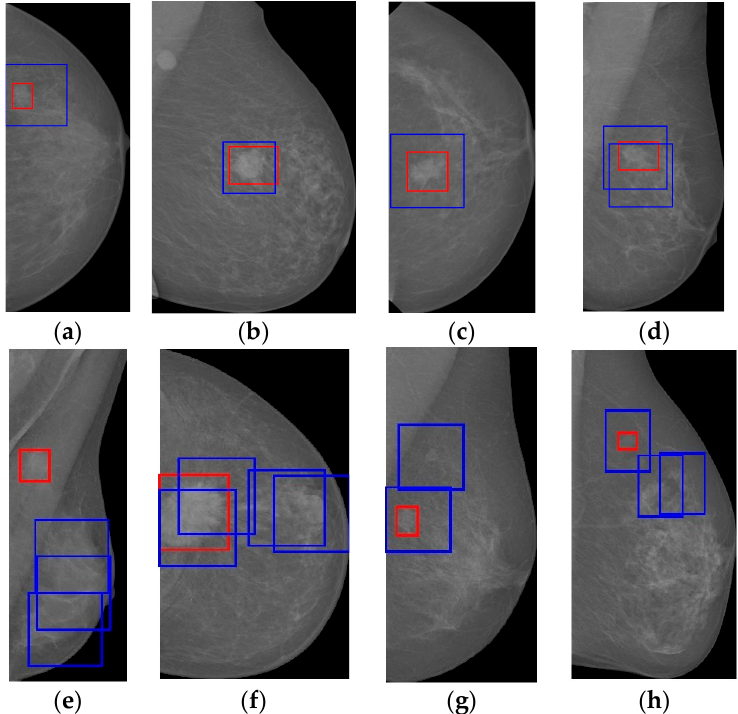
Figure 9. Detection examples on INbreast by VGG19 with false positive reduction and NMS. The red rectangles indicate the ground truth of masses while the blue rectangles stand for the detection results. ( a ) Detected mass: 1, true mass: 1, FPI: 0. ( b ) Detected mass: 1, true mass: 1, FPI: 0. ( c ) De-